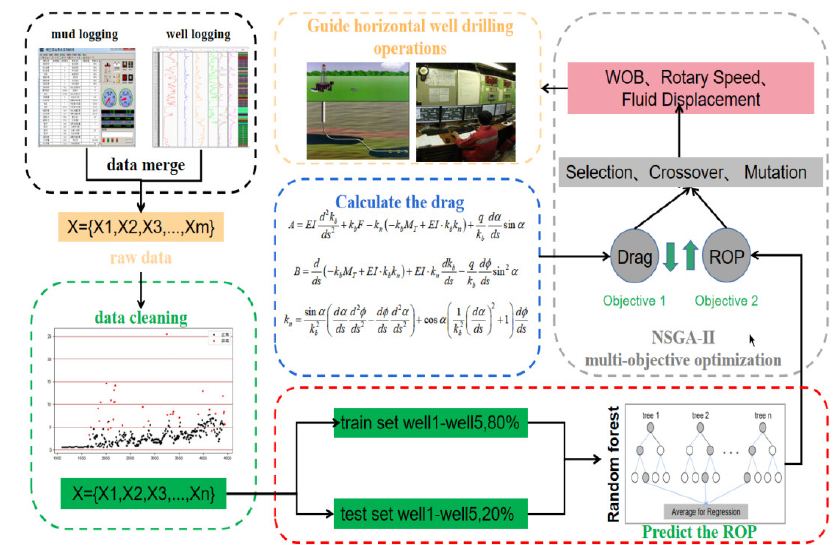
Figure 1. The workflow of multiobjective drilling parameters optimization.